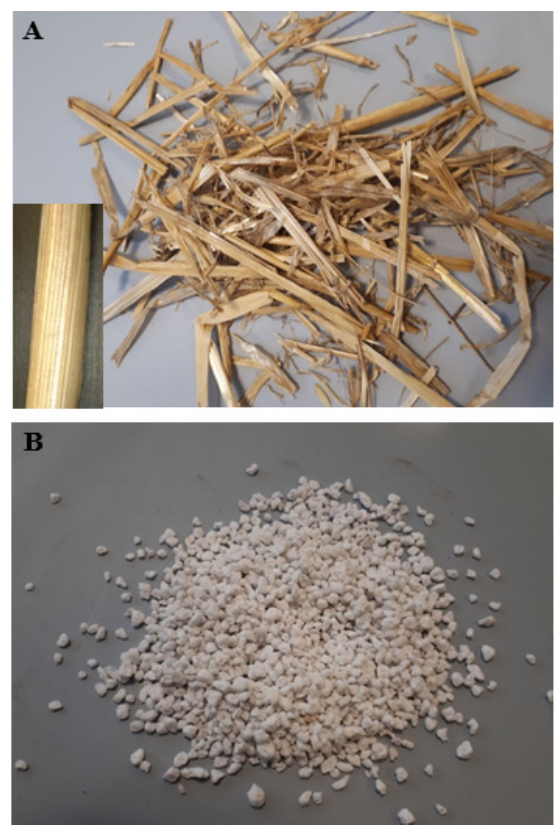
Figure 1. ( A ) Straw before use and, in the inset, after cutting. ( B ) Perlite beads.